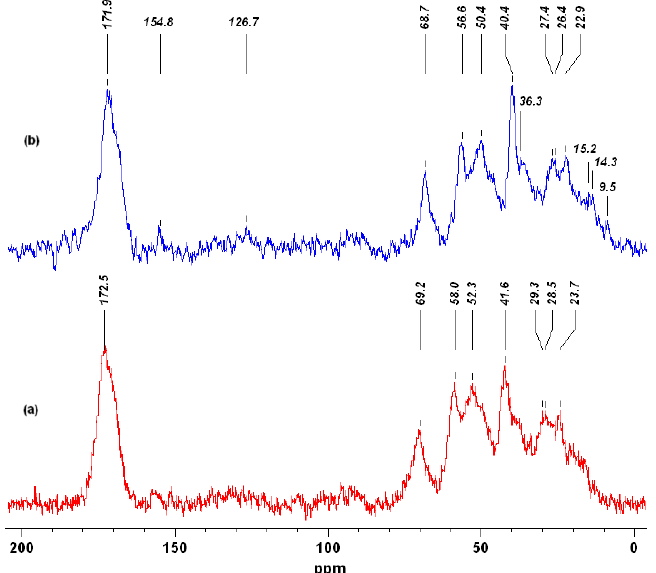
Figure 6. 13 C CP/MAS NMR spectra of H. communis sponge skeletons ( a ) and developed hybrid material ( b ) (750 mg/L; 30 min; pH neutral; 0.1 M NaCl) (additional signals are written horizontally).